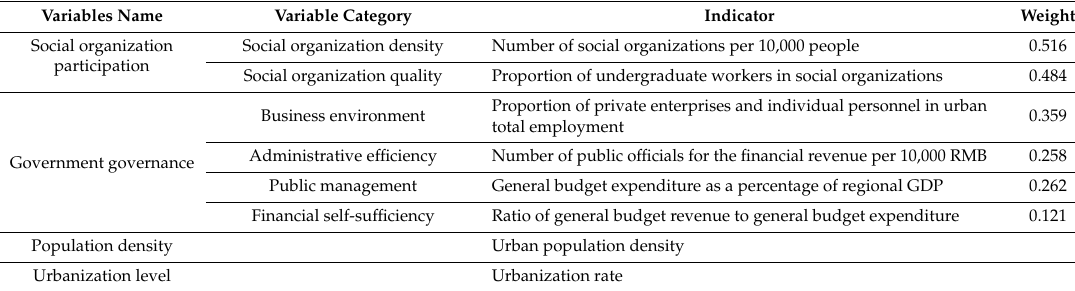
Table 2. Independent and control variables and